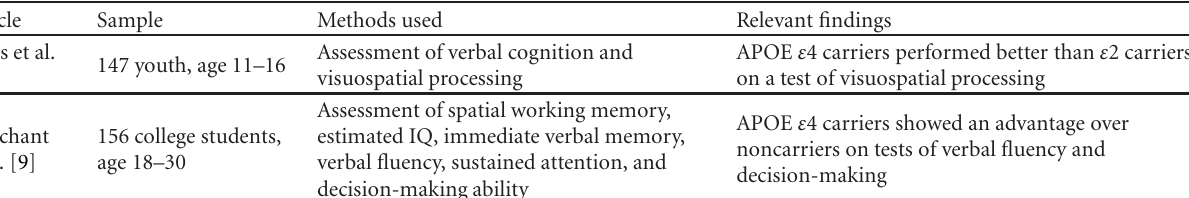
Table 1: Samples, methods, and relevant findings of reviewed